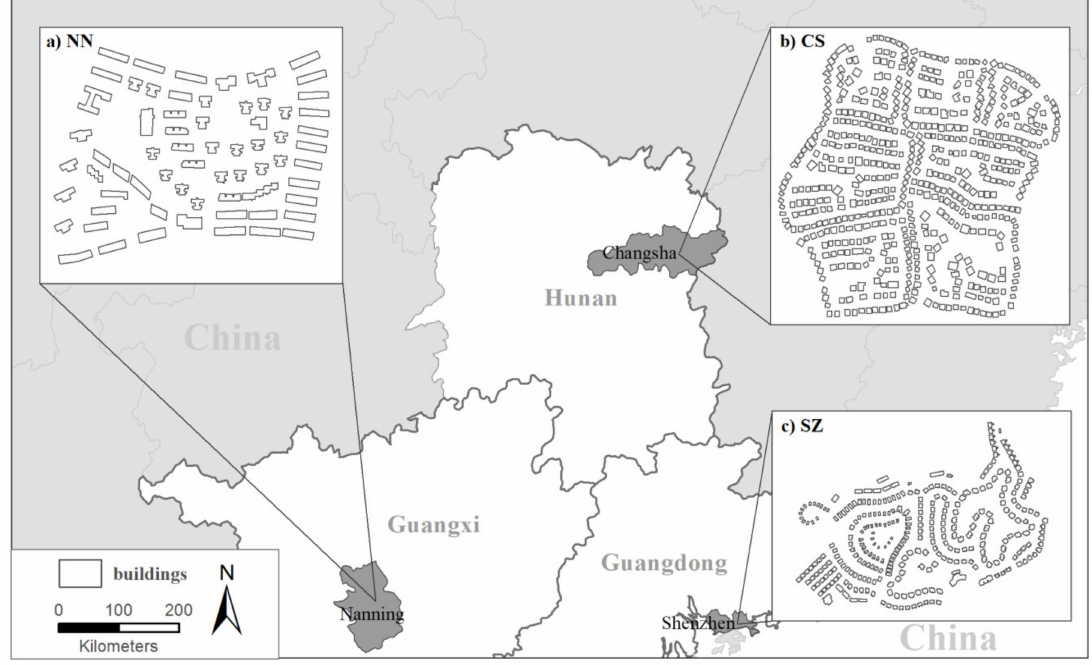
Figure 7. Location of the study area and experimental datasets are shown for ( a ) NanNing; ( b ) ChangSha; ( c )